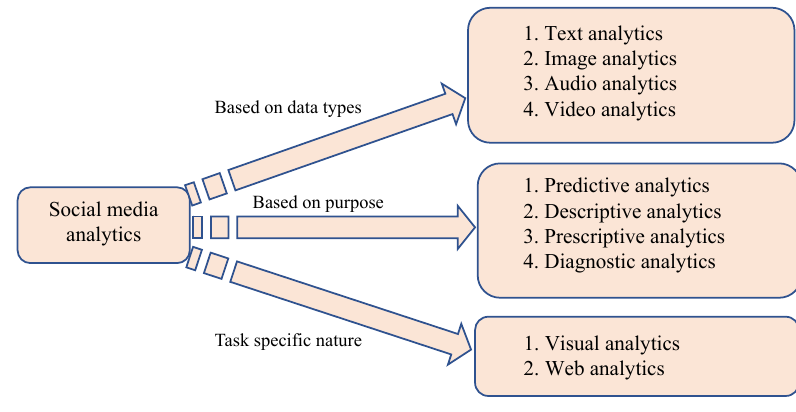
Fig. 5 Taxonomy in social data